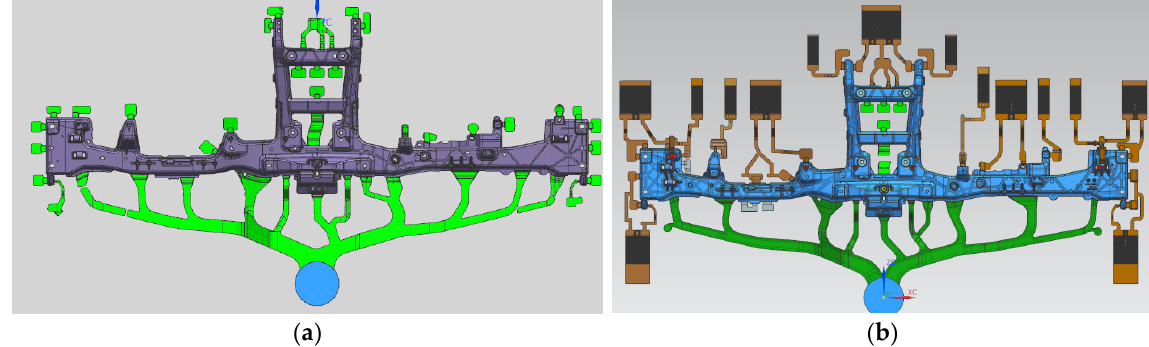
Figure 1. 3D model with pouring system: ( a ) scheme 1; ( b ) scheme 2.